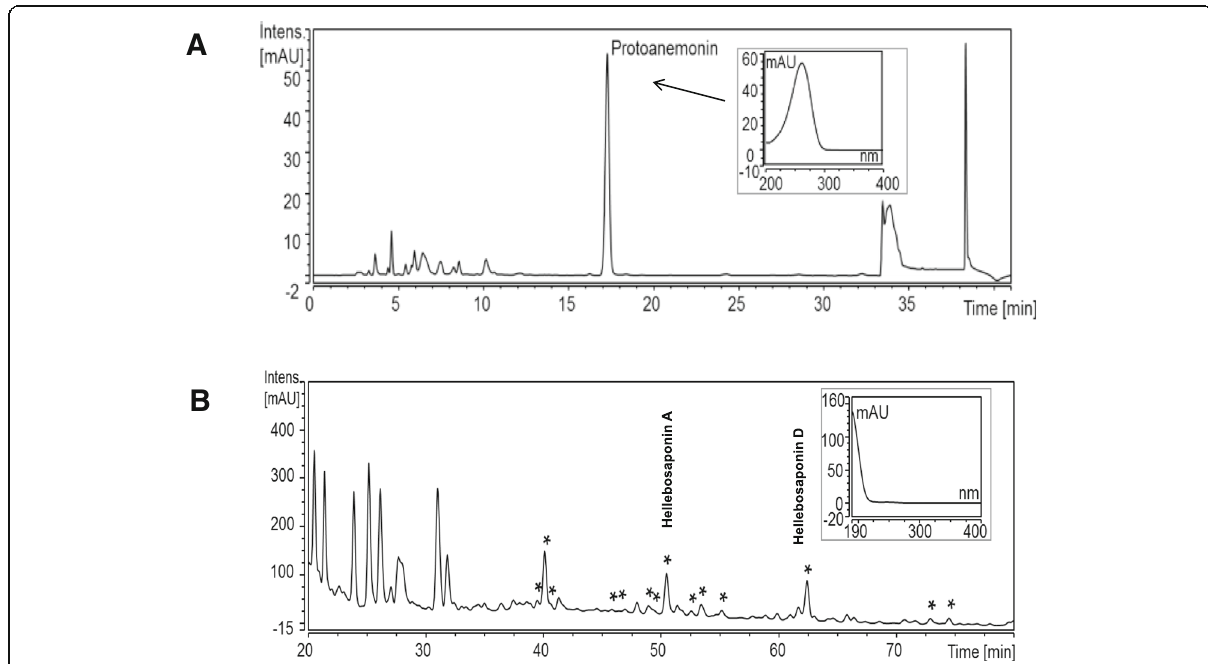
Fig. 2 HPLC-DAD of an aqueous fermented Helleborus niger extract. a : HPLC-DAD chromatogram ( λ = 261 nm) of an aqueous fermented Helleborus niger extract (1:20 dilution in water) and UV/Vis spectrum of protoanemonin. b : HPLC-DAD chromatogram ( λ = 210 nm) of an aqueous fermented Helleborus niger extract and exemplary UV/Vis spectrum of a saponin. *